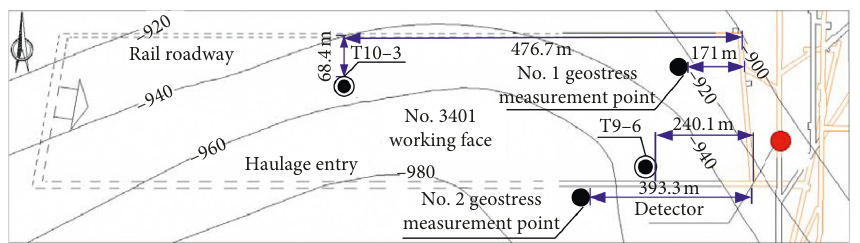
Figure 1: Layout of No. 3401 working face.